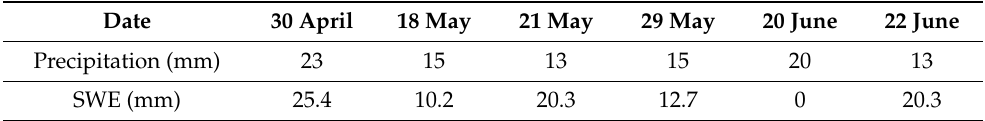
Table 2. Late-season storm events recorded at the Joe Wright SNOTEL Station for the 2019 season.